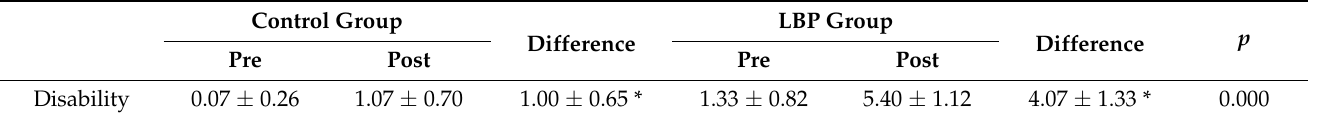
Table 3. Subject scores of disability before and after 30 min of sitting.